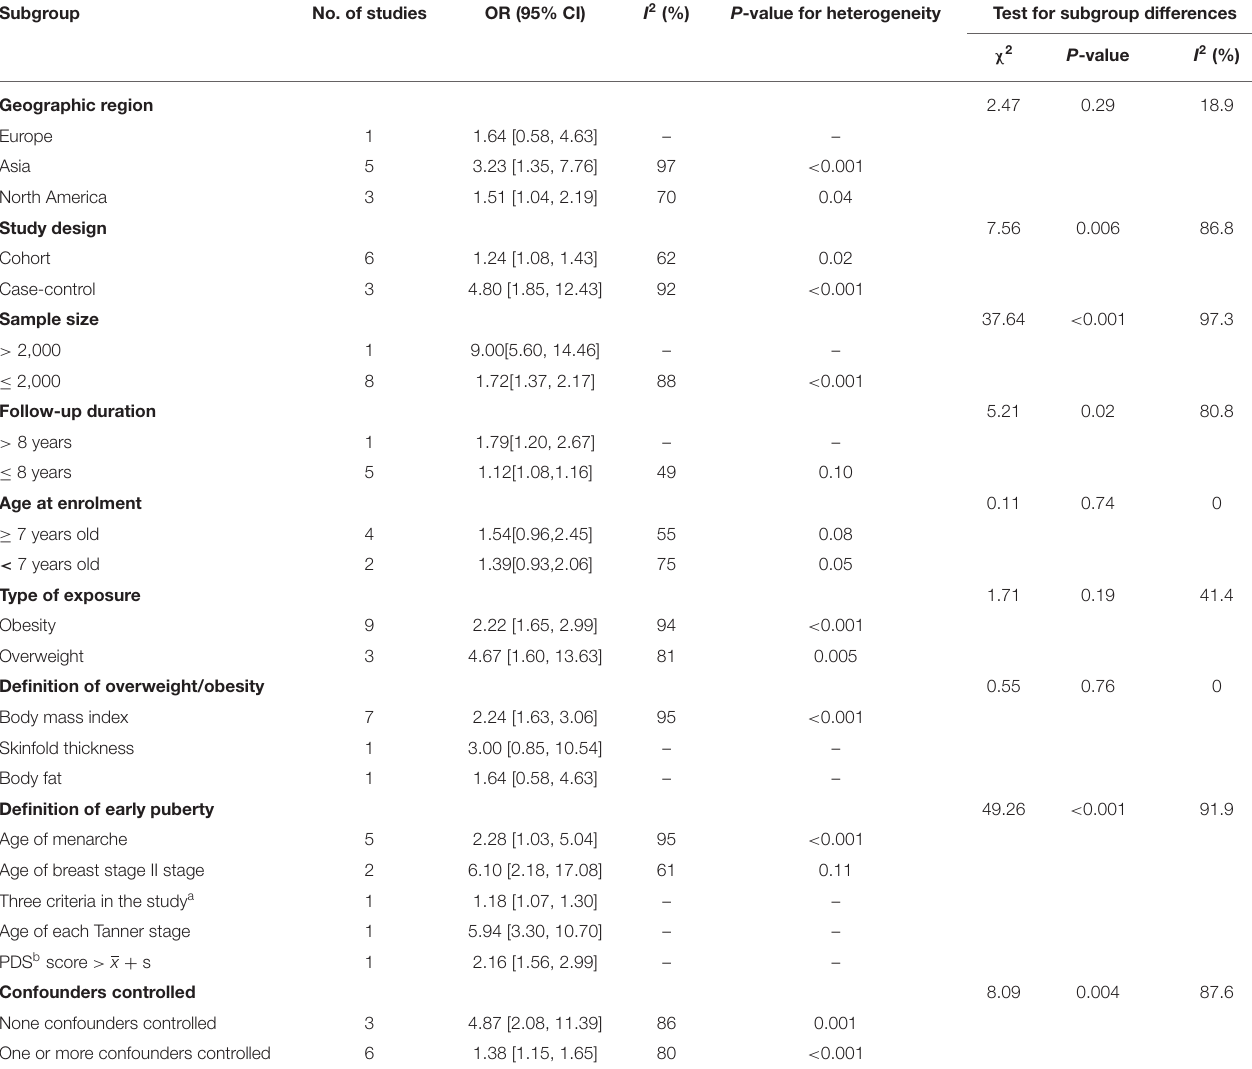
TABLE 4 | Subgroup analyses for the association between childhood overweight/obesity and early puberty in girls. Subgroup